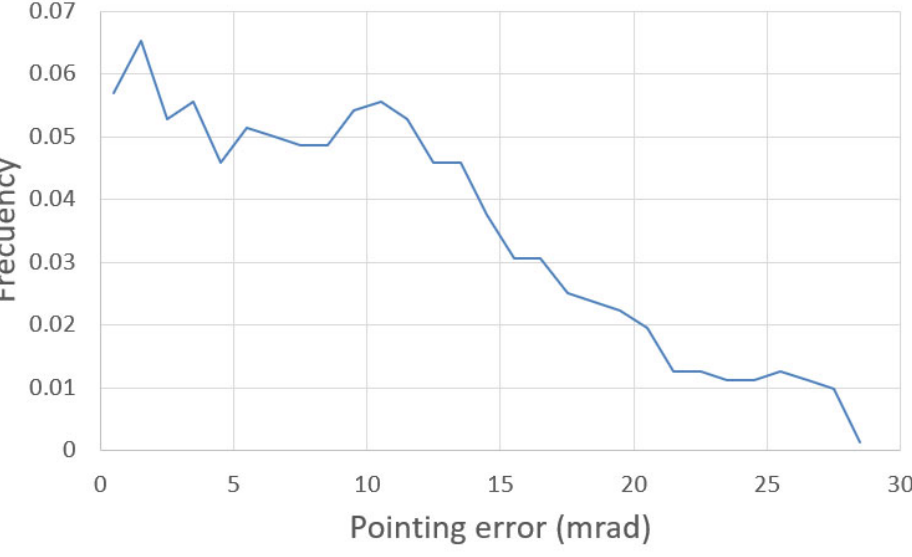
Figure 17. Frequency histogram of the proposed pointing error ξ .